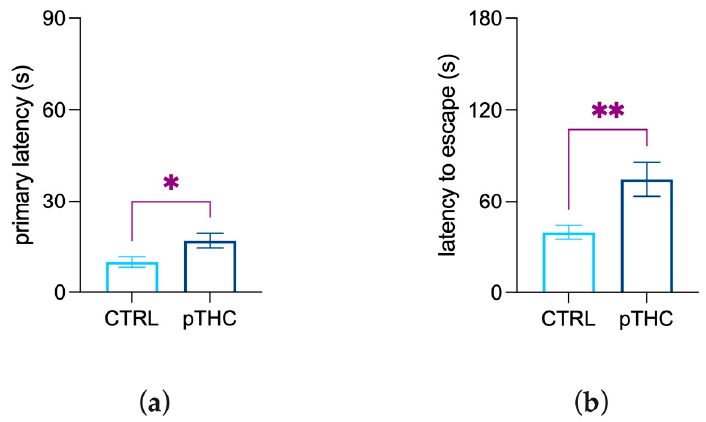
Figure 7. Effect of prenatal THC exposure (2 mg/kg) on the spatial memory and reversal learning of the adolescent male rat offspring in the Barnes maze test. pTHC increased: ( a ) primary latency and ( b ) latency to escape in the probe and reversal tasks, respectively. Each bar represents the mean of n = 12 rats; error bars indicate SEM. * p < 0.05; ** p < 0.01; CTRL = male rat offspring prenatally exposed to Veh; pTHC = male rat offspring prenatally exposed to THC.